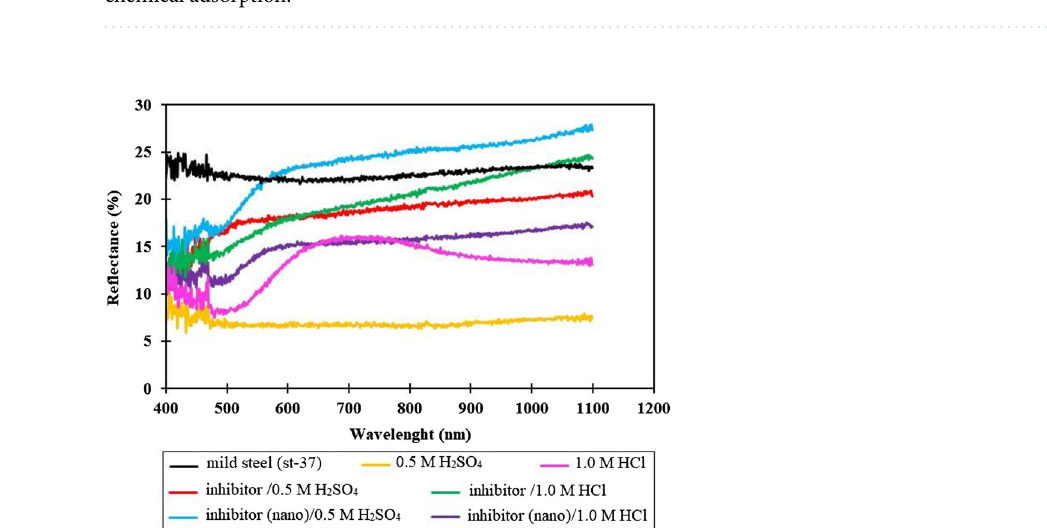
Figure 9. Mechanism of corrosion inhibition adsorption on the metal surface: ( a ) physical adsorption, and ( b ) chemical adsorption.